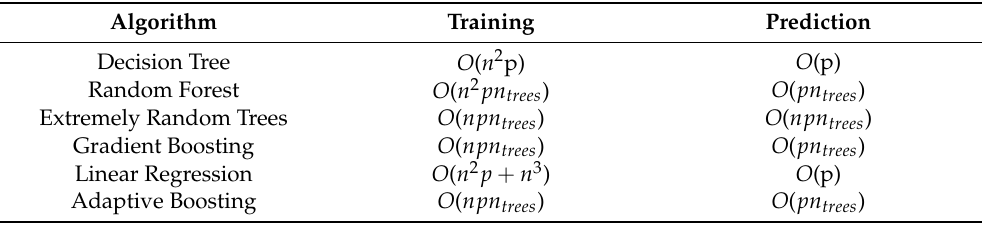
Table 3. Complexity of algorithms ( n the number of samples, p the number of features, n trees the number of